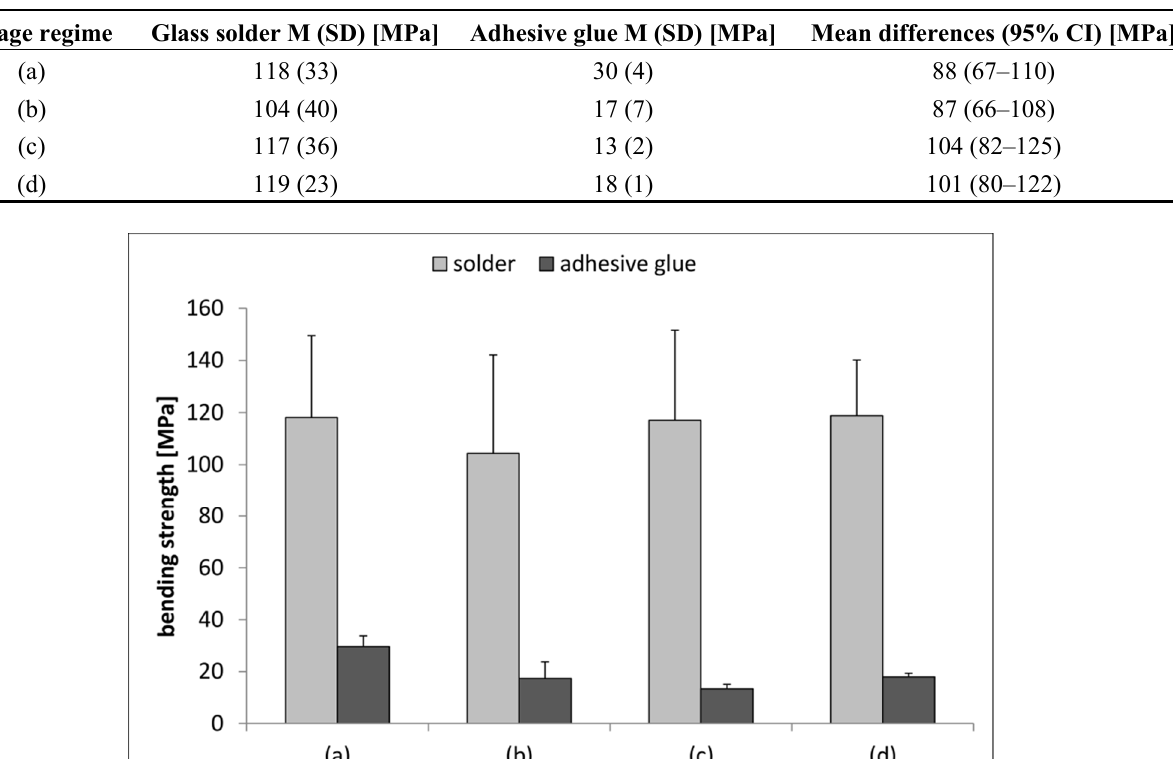
Table 1. Obtained bending strength (mean value (M) and standard deviation (SD)) for soldered and glued compound samples in native condition ( a ); after 30 or 90 days in humid condition ( b ) and ( c ), respectively; and after artificial aging ( d ). Furthermore, the mean differences between the bonding methods as well as the boundaries of the 95% confidence interval are listed.